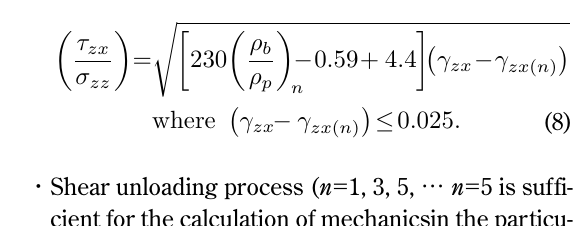
Fig. 14 . Relation between shear stress and strain ( σ zz =